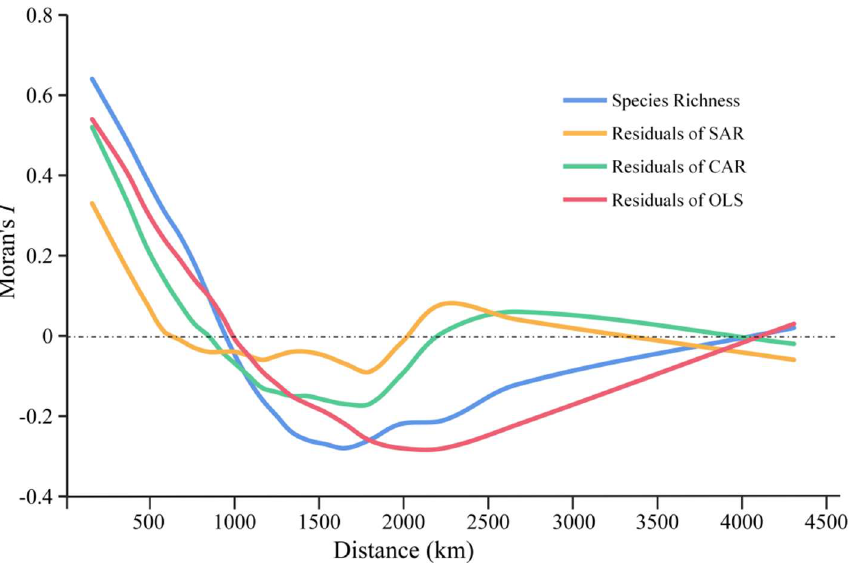
Figure 5. Moran’s I correlogram for the residuals of OLS, CAR, and SAR models. Table 1. Relationships between the richness of endemic taxa of Viburnum and explained variables using simple ordinary least squares (OLS) model, simple conditional autoregressive (CAR) model and the simultaneous autoregressive in (SAR) model.